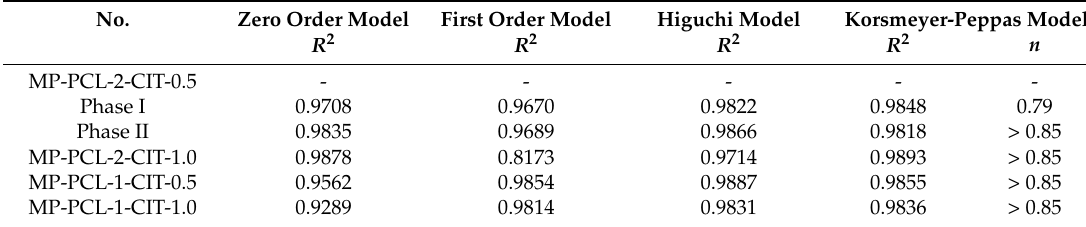
Table 3. Analysis data of CIT release from